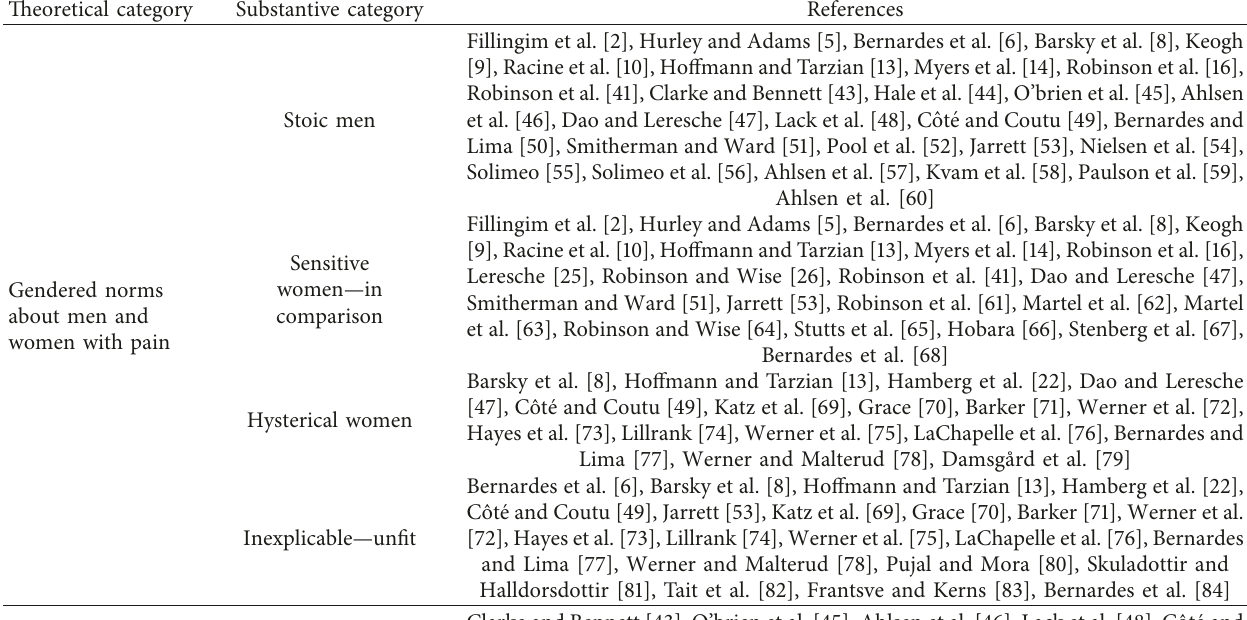
Table 2: Theoretical categories, substantive categories, and referenced articles; 77 articles